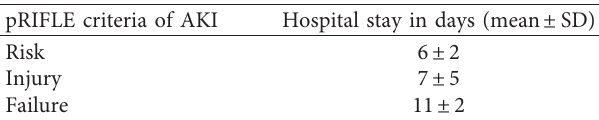
Table 7: Duration of hospital stay in children with AKI. pRIFLE criteria of